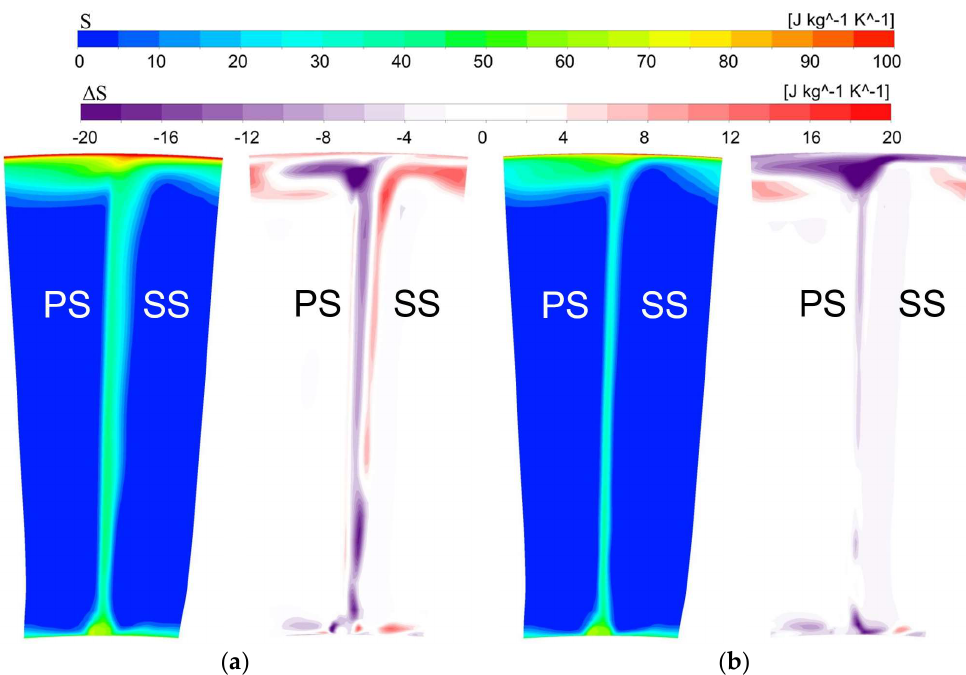
Figure 9. Entropy distribution with wake and its difference with no wake at the rotor outlet. ( a ) Re = 1 × 10 5 ; ( b ) Re = 4 × 10 5 .